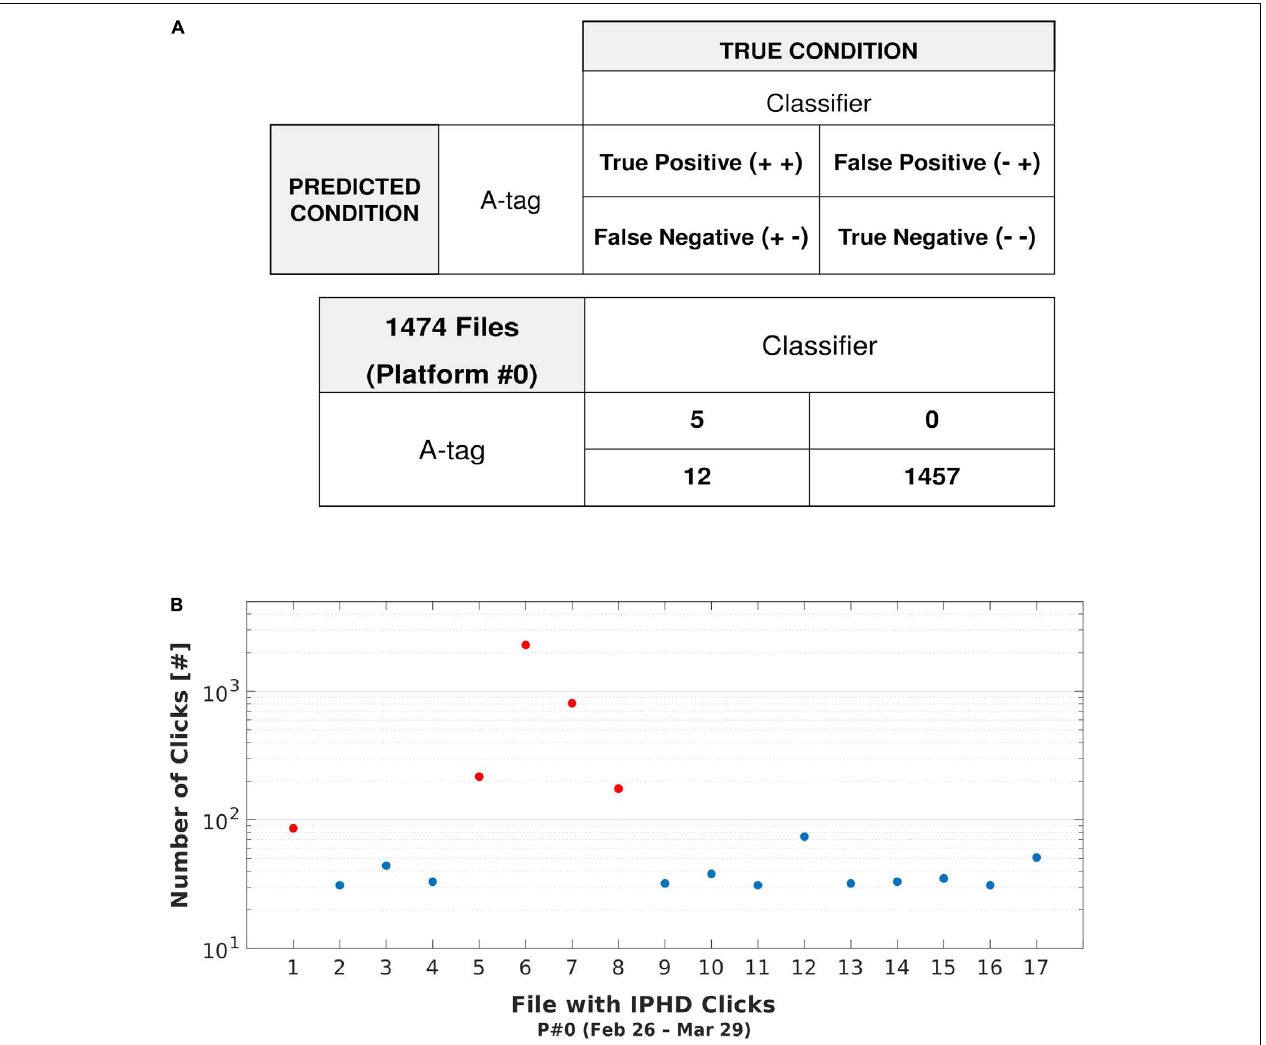
FIGURE 11 | Comparison with A-tag Data Logger. (A) A confusion matrix shows the comparison between A-tag performance and the Cubic SVM. (B) Scatterplot showing the number of clicks detected for files classified as true positive (red dots) and false negative (blue dots). For all of these files, the presence of clicks was confirmed by manual analysis (spectrogram